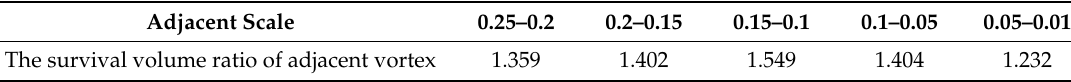
Figure 11. The survival volume of different scale eddies at 100%Pn. Table 3. Survival volume ratio of adjacent scale vortex in runner at